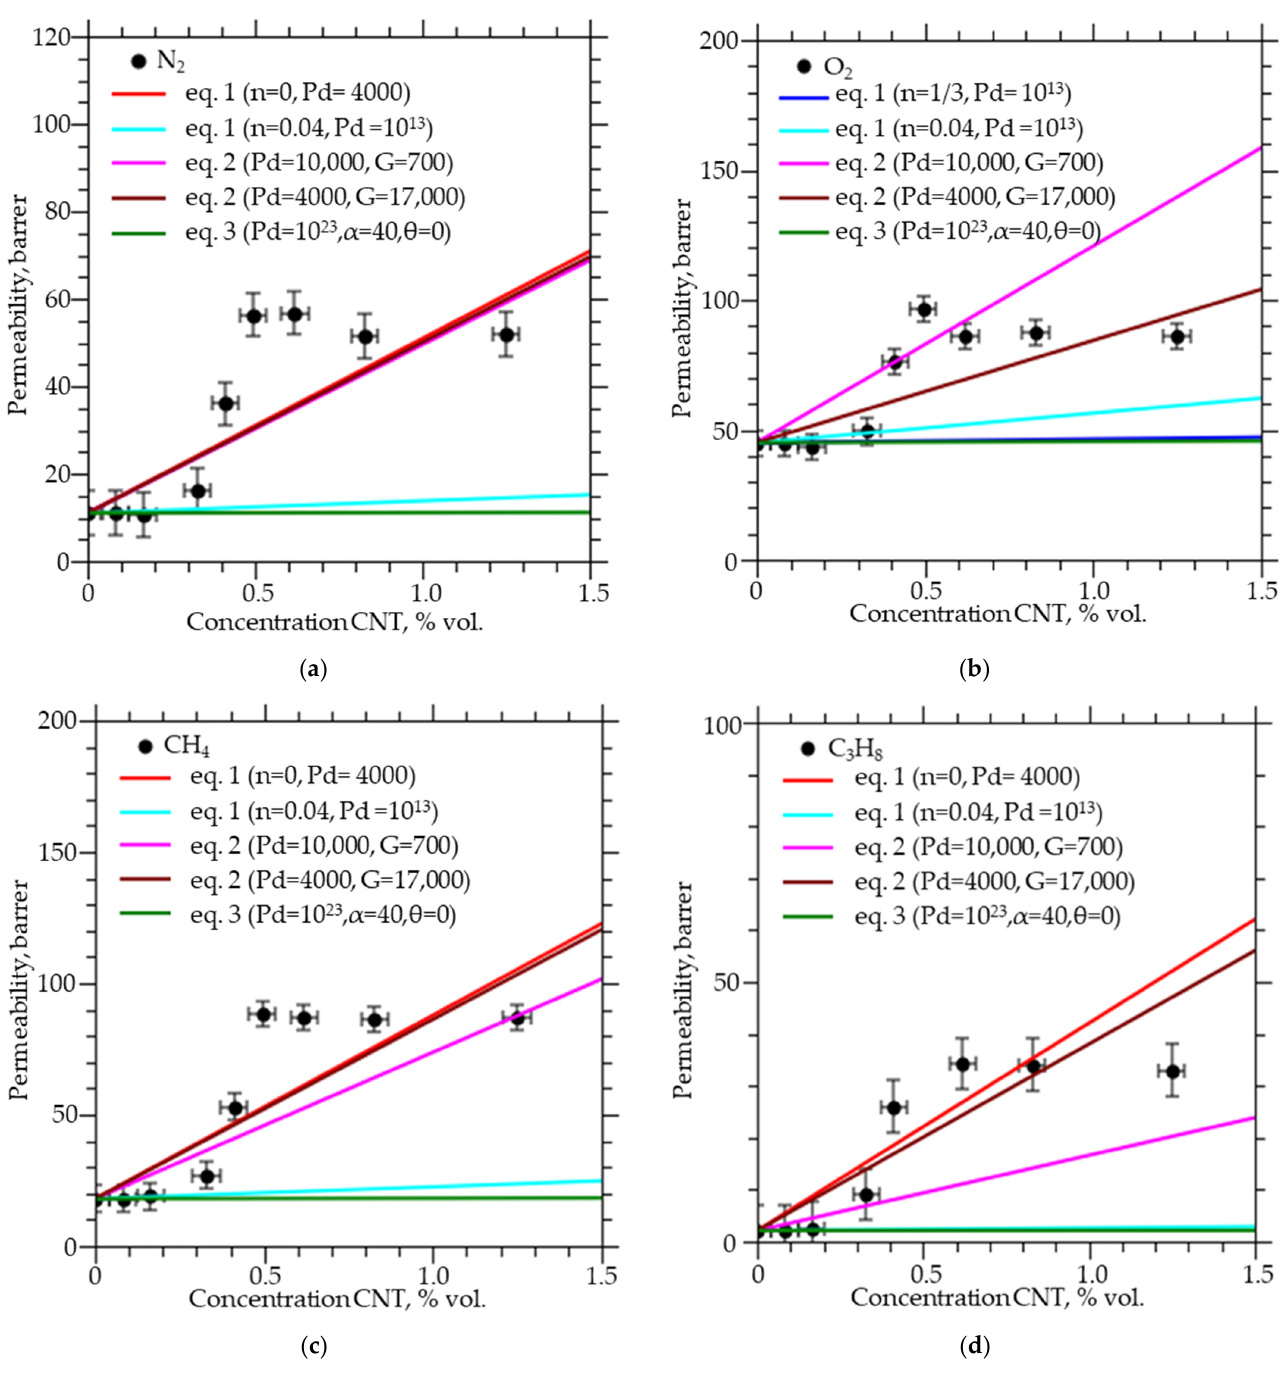
Figure 1. Permeability coefficients of ( a ) nitrogen, ( b ) oxygen, ( c ) methane, and ( d ) propane through PVTMS membranes with different CNTs concentrations and calculation by models.